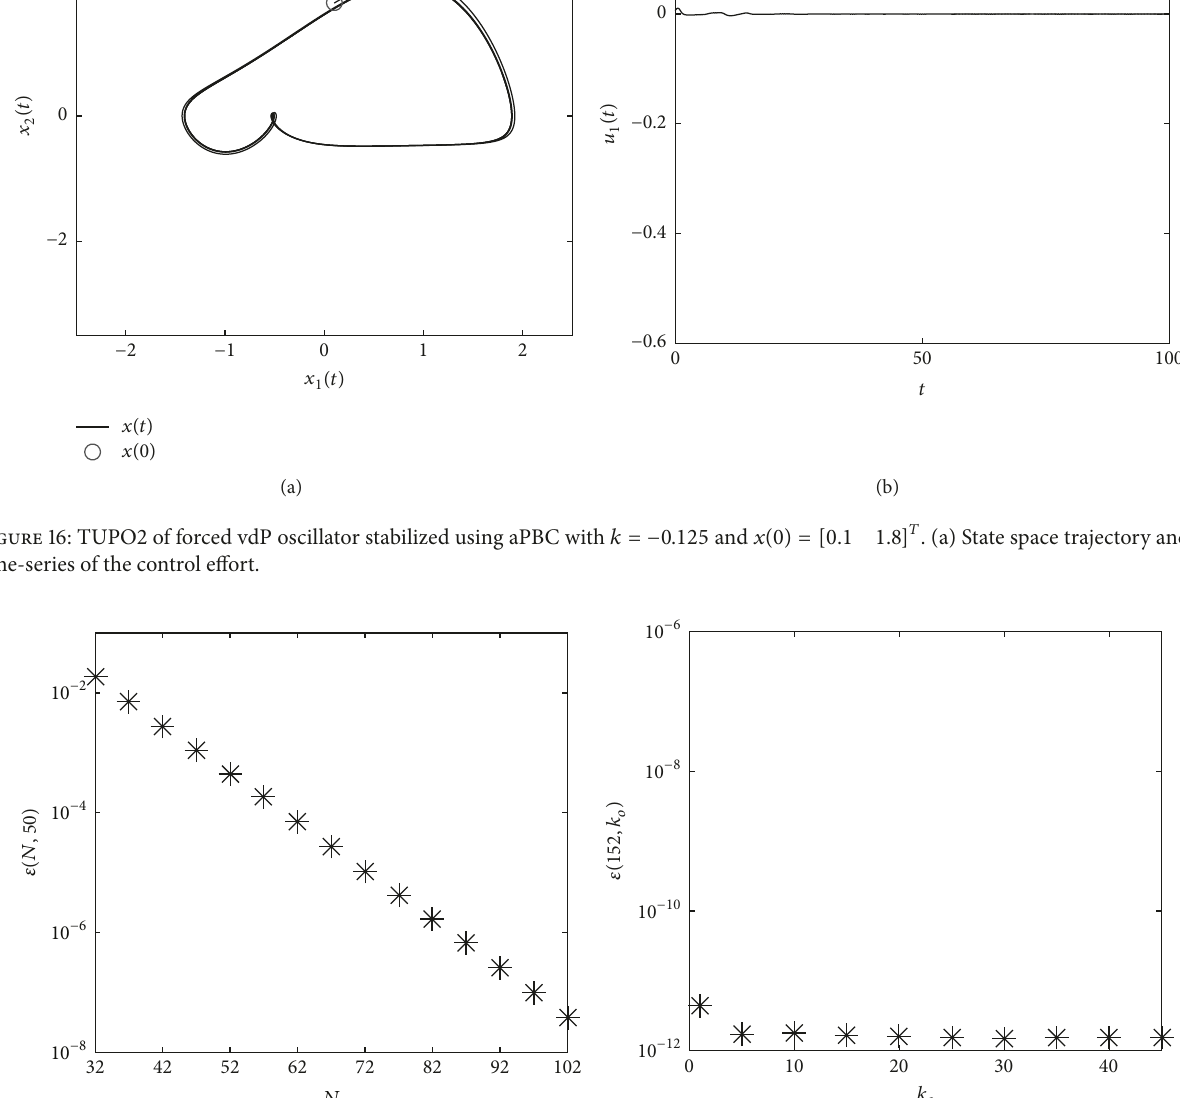
values 𝑁 . From Figure 17, values 𝑁 = 102 and 𝑘 𝑜 = 10